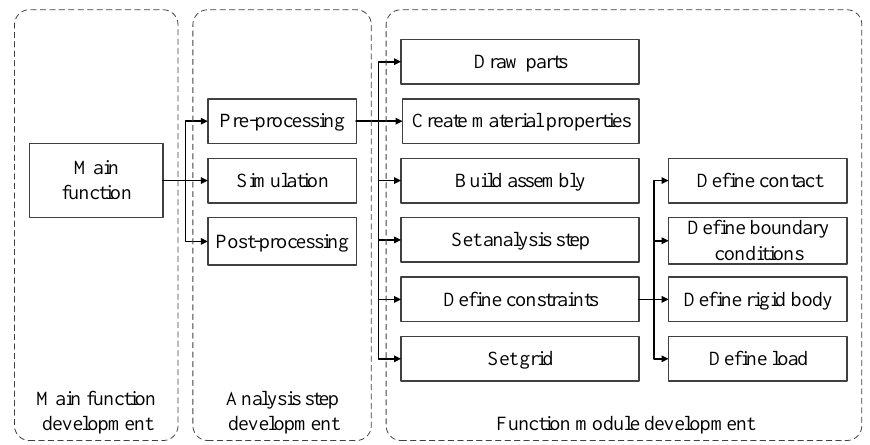
Figure 6. The parameterized model structure.